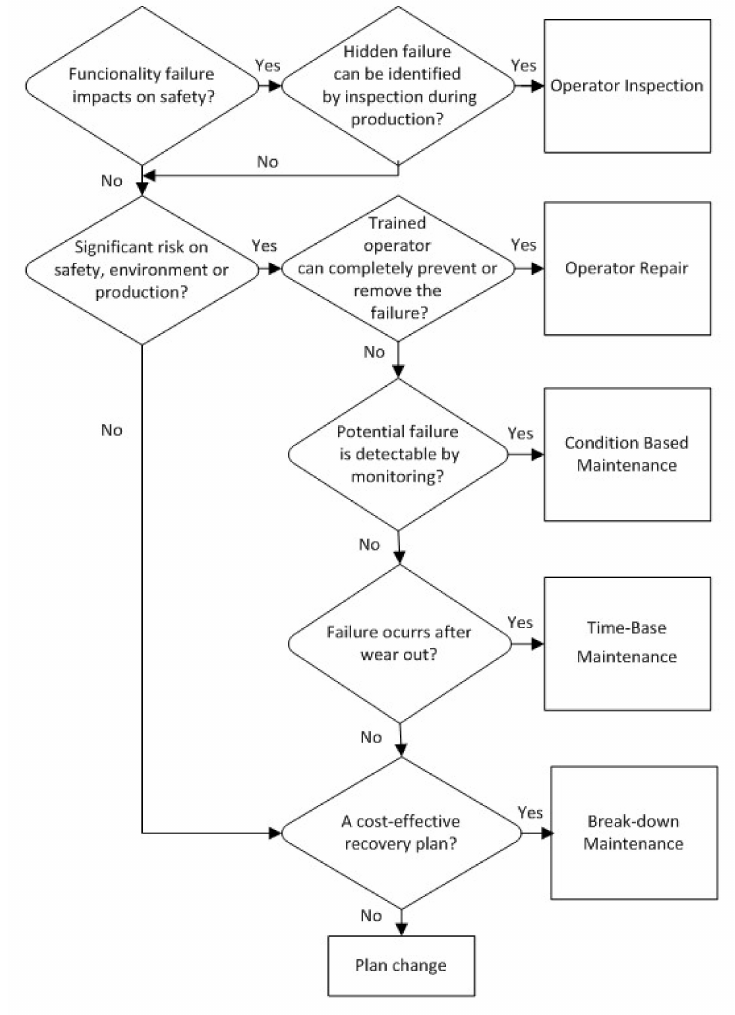
Figure 2. Detail of the RCM decision diagram; adapted from